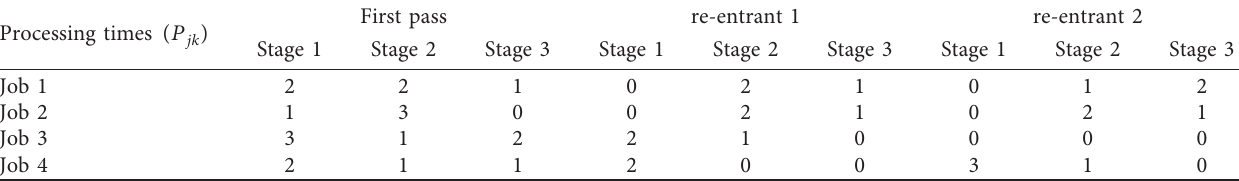
Table 1: Processing times of the four-job and three-stage example (hour).